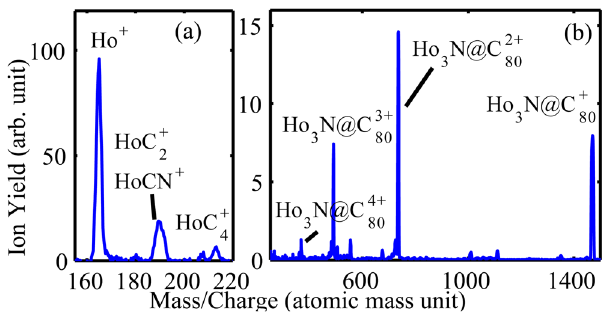
Figure 1. Mass/charge spectra of Ho 3 N@C 80 ionized with laser pulses of 800 nm, 30 fs pulse duration and an intensity of 4 × 10 14 W/cm 2